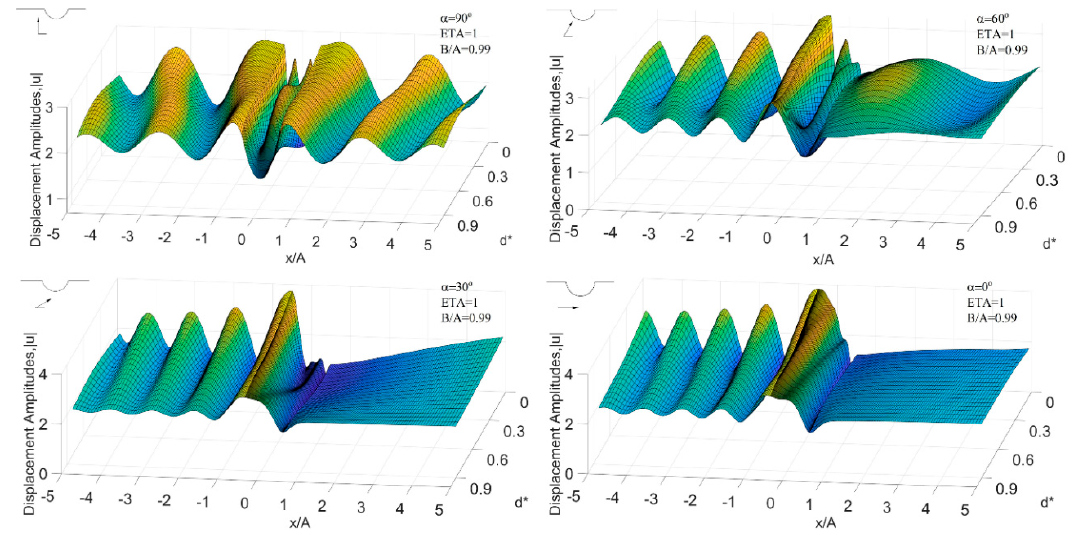
= 0 α= ° 30 ° 60 ° when , , , and